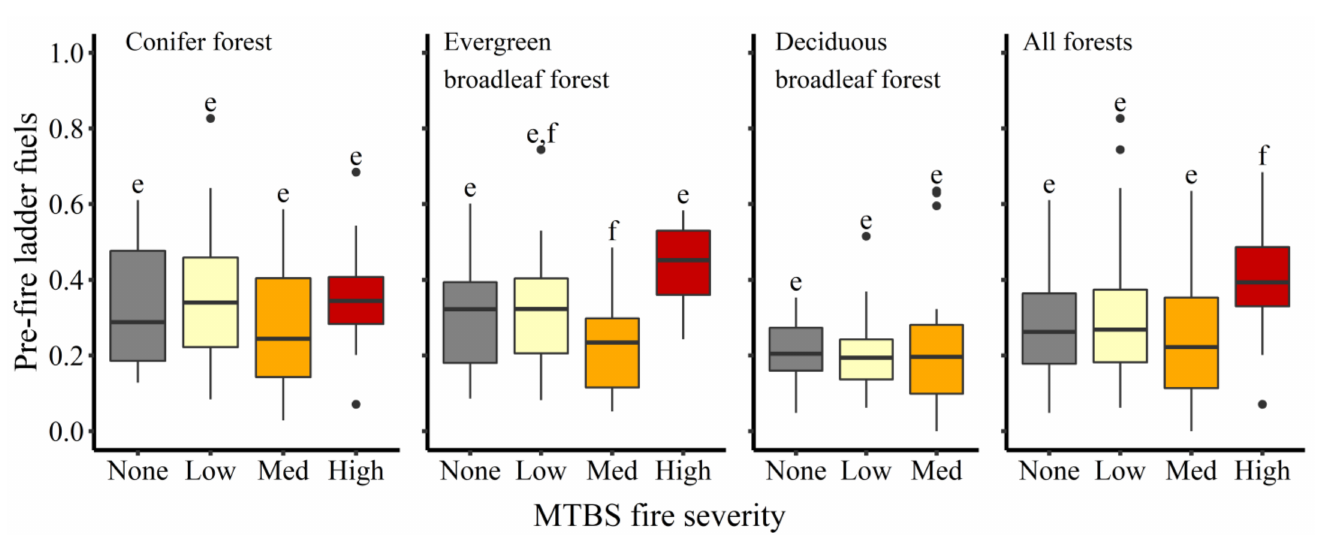
Figure 7. Relationship among pre-fire ladder fuels derived from 2013 ALS data and 2017 Tubbs fire burn severity by forest types. Lower case letters represent statistically similar groups at the 95% confidence level using a Dunn’s post-hoc